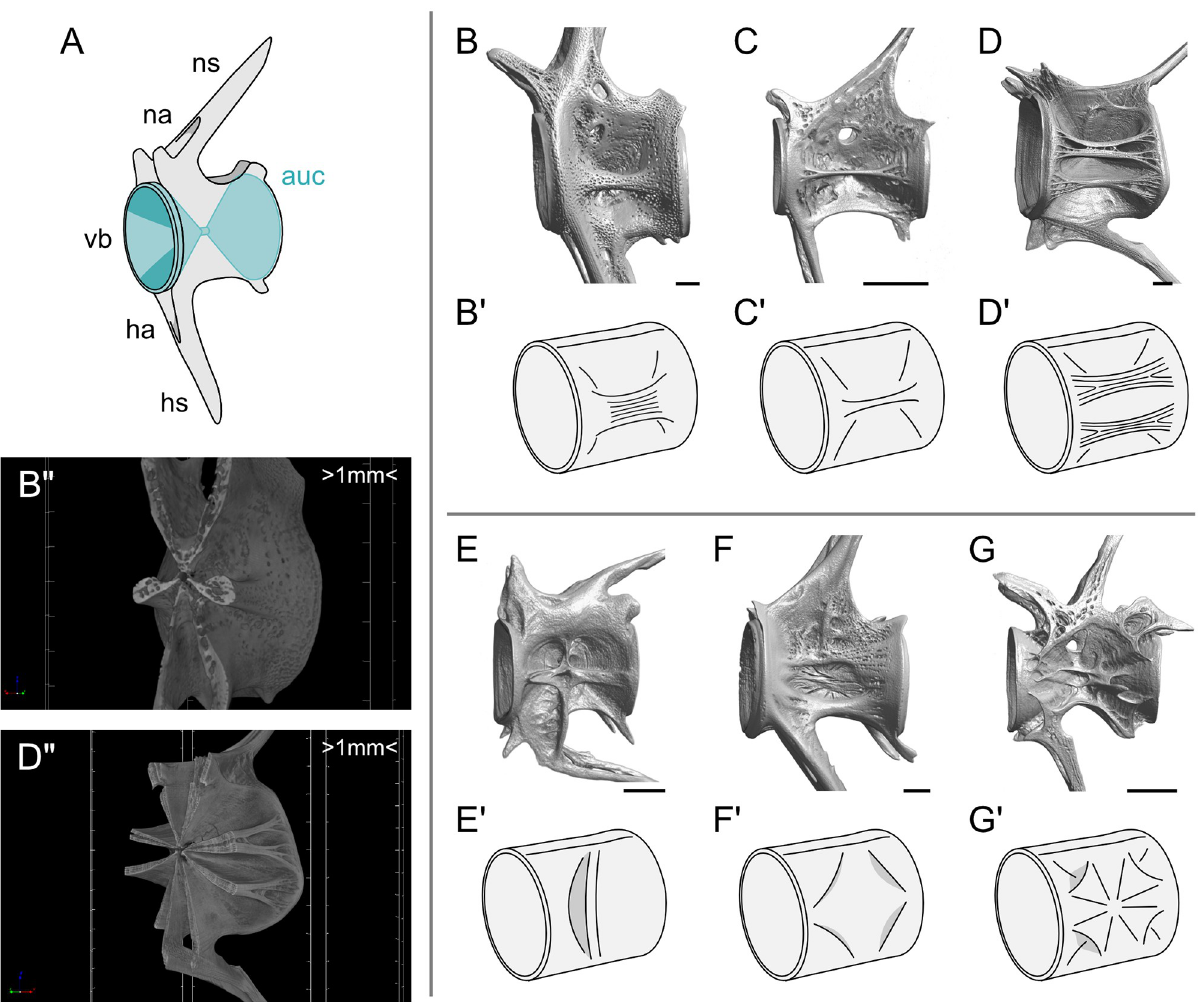
Fig 1. Anatomy of fish vertebrae. (A) Structure of the fish vertebrae. Abbreviations: auc: autocentrum; ns: neural spine; na: neural arch; vb: vertebral body; ha: hemal arch; hs: hemal spine. (B–G) Volume-rendered micro-computed tomography (micro-CT) images of left lateral views of the caudal vertebral bodies of (B) Pagrus major , (C) Acropoma hanedai , (D) Zenopsis nebulosa , (E) Muraenesox cinereus , (F) Scarus forsteni , and (G) Macroramphosus sagifue . (B’–G’) Schematic illustrations of the morphological features of (B–G) that displays (B) a single thick longitudinal plate-like ridge (thick trabecula), (C) a single thin longitudinal plate-like ridge, (D) two longitudinal plate-like ridges, (E) a transverse plate-like ridge, (F) hump- like structures rising on the edge of the vertebral body, (G) tarp-like triangle ridges extending from the center to the edge of the vertebral body. (B” and D”) Transverse sections at the midpoint of the vertebral bodies of (B”) P. major and (D”) Z. nebulosa . These images indicate that the lateral ridges extend from the vertebral body center. Scale bars: (B–F) 1 mm, and (G) 500 μ m. In (B” and D”), the interval between scale markers is 1